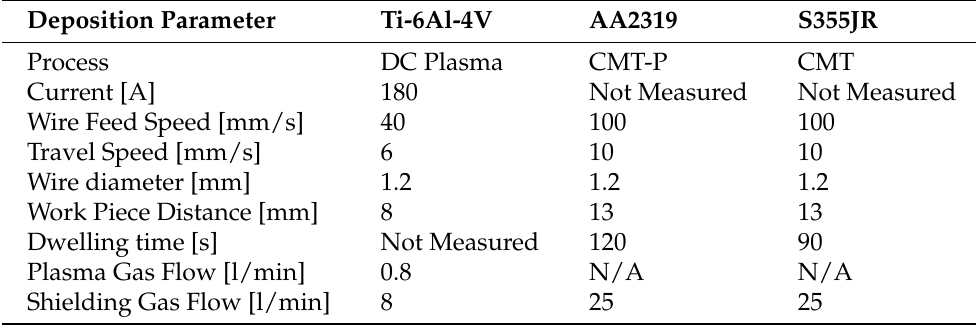
Table 2. Welding parameters for WAAM-fabricated